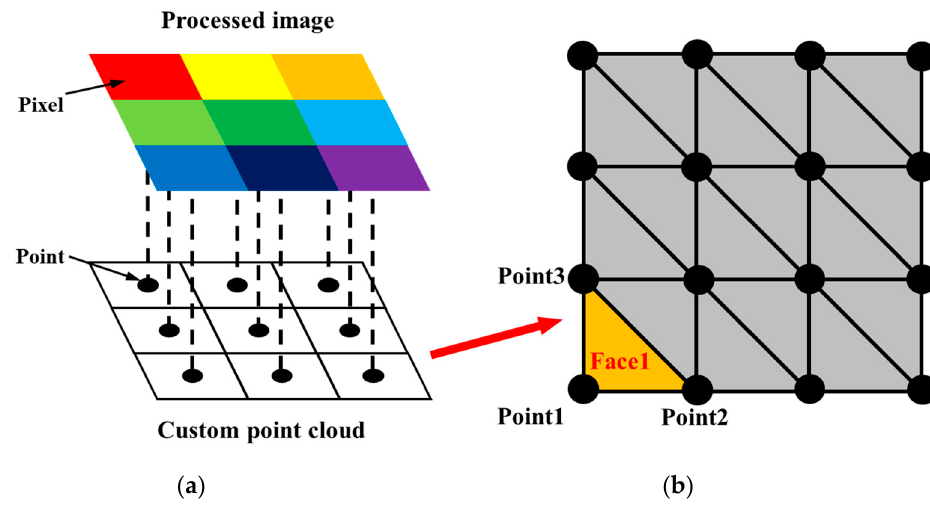
Figure 17. Custom 2D point cloud creation and generation of the 2D mesh: ( a ) generating the custom 2D point cloud from the RGB image, and ( b ) schematic diagram of the diagonal mesh method.